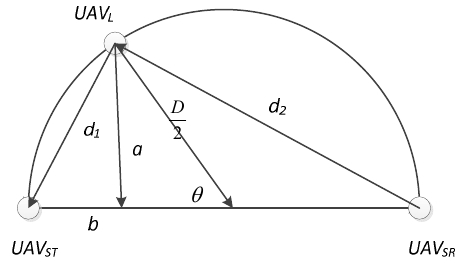
Figure 4. The illustration of distance when θ > π /2.